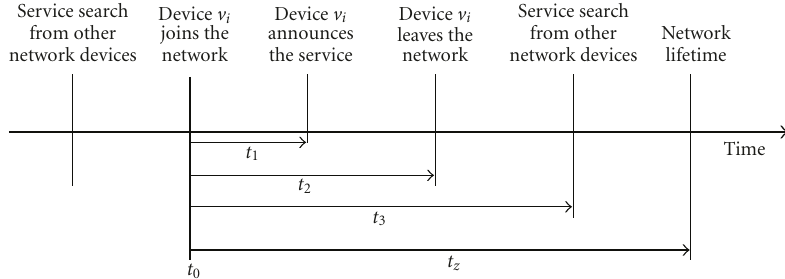
Figure 2: Reference times when a device v i joins and leaves the spontaneous network.